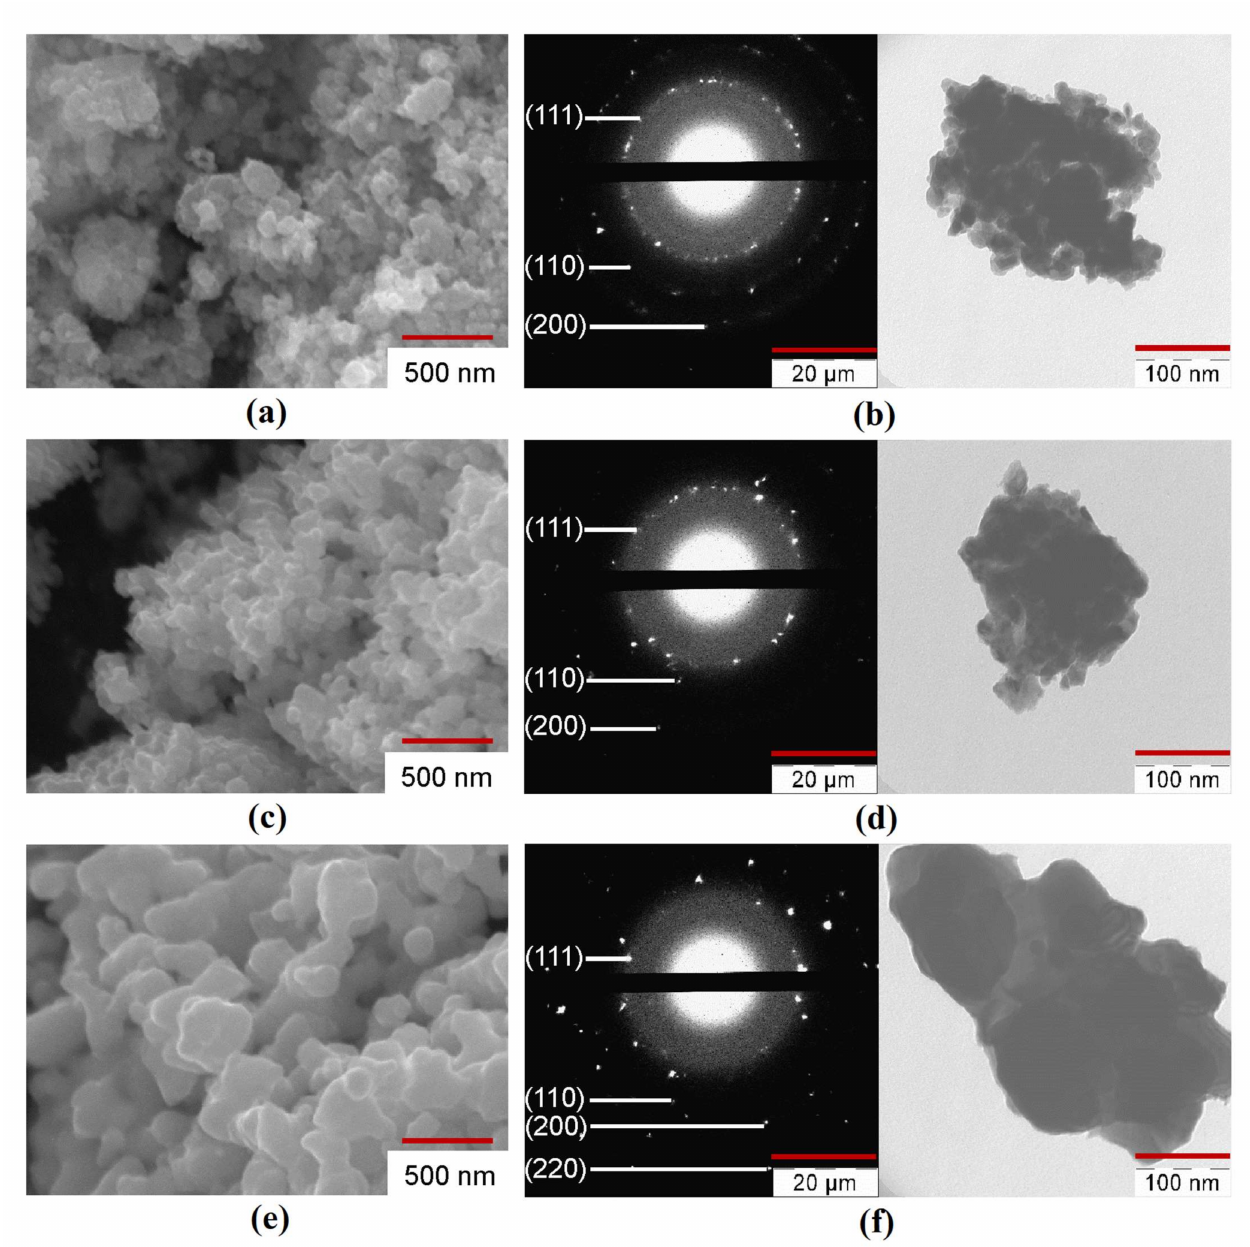
Figure 5. Scanning electron microscope (SEM), transmission electron microscope (TEM) images, and Selected area electron diffraction (SAED) patterns of Fe–Co–Ni nanocomposites ( a , b ) 1Fe–Co–Ni T R = 300 ◦ C, ( c , d ) 3Fe–Co–Ni T R = 400 ◦ C, ( e , f ) 5Fe–Co–Ni T R = 500 ◦